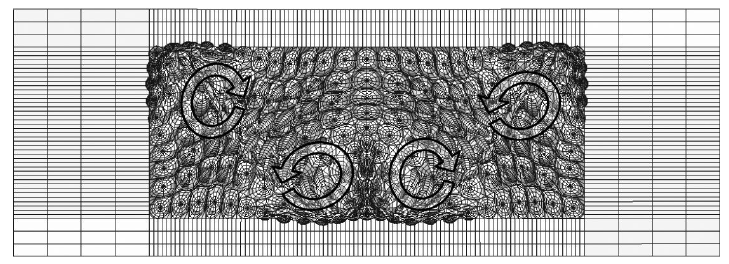
Fig. 49. EIDL 9th mode – 974 Hz – in plane quadruple opposite swirl